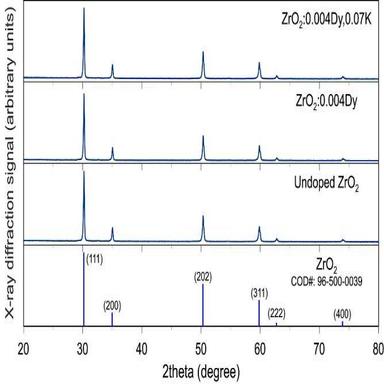
XRD patterns of the ZrO2, ZrO2:0.004Dy3+, and ZrO2:0.004Dy3+,0.07K+. As a guide, the standard card of ZrO2 (COD: 96-500- 0039) is presented.